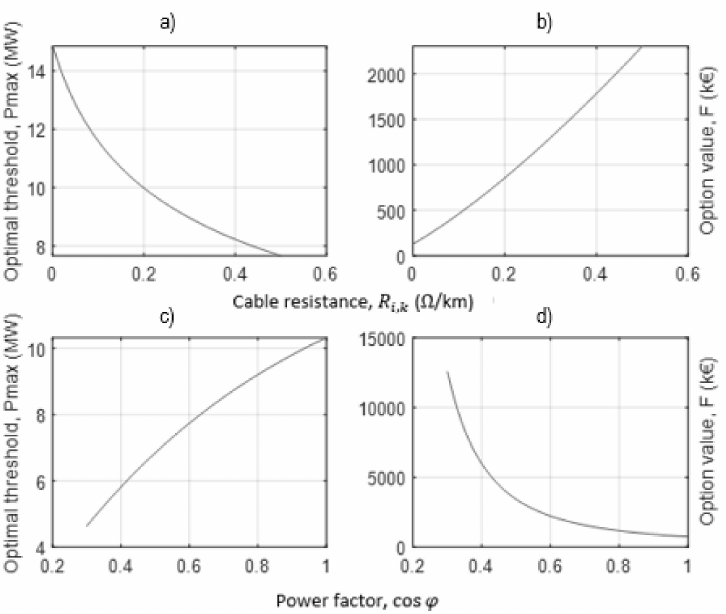
Figure 18. Sensitivity analysis of cable resistance and power factor for optimal threshold ( a , c ) and option value ( b , d